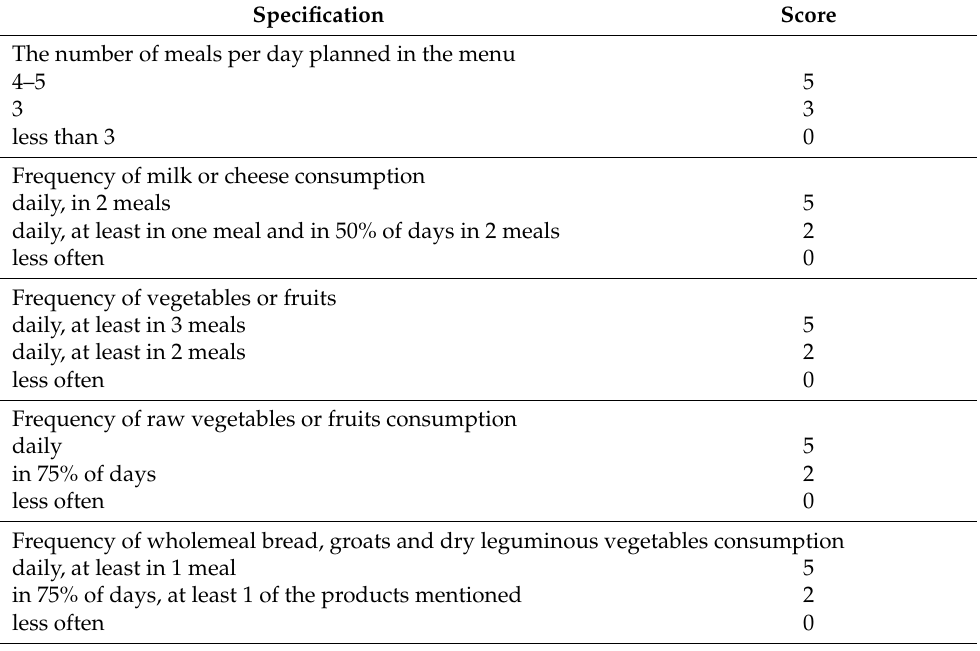
Table 2. Modifed Starzy´nska’s test used to study nutritional